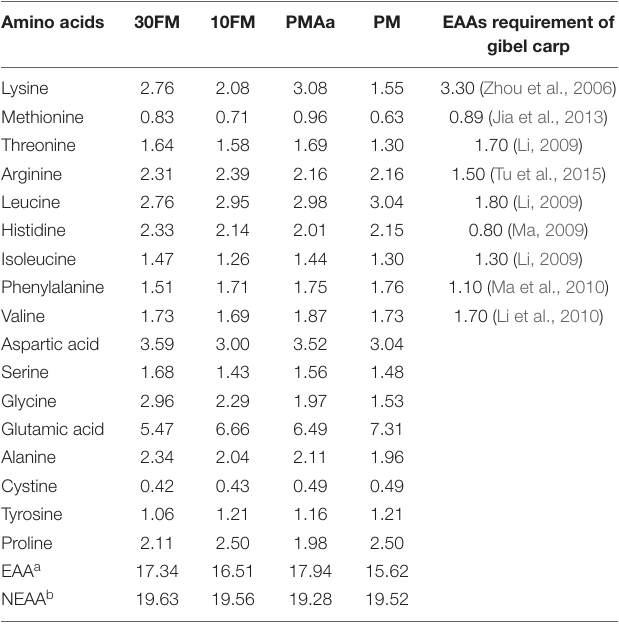
TABLE 3 | Amino acid content of the experimental diets (g/100 g dry